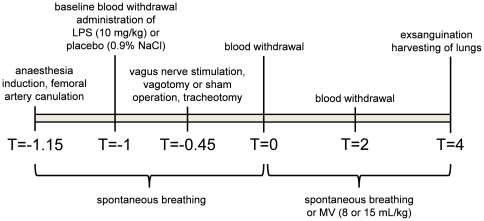
Experimental procedures.